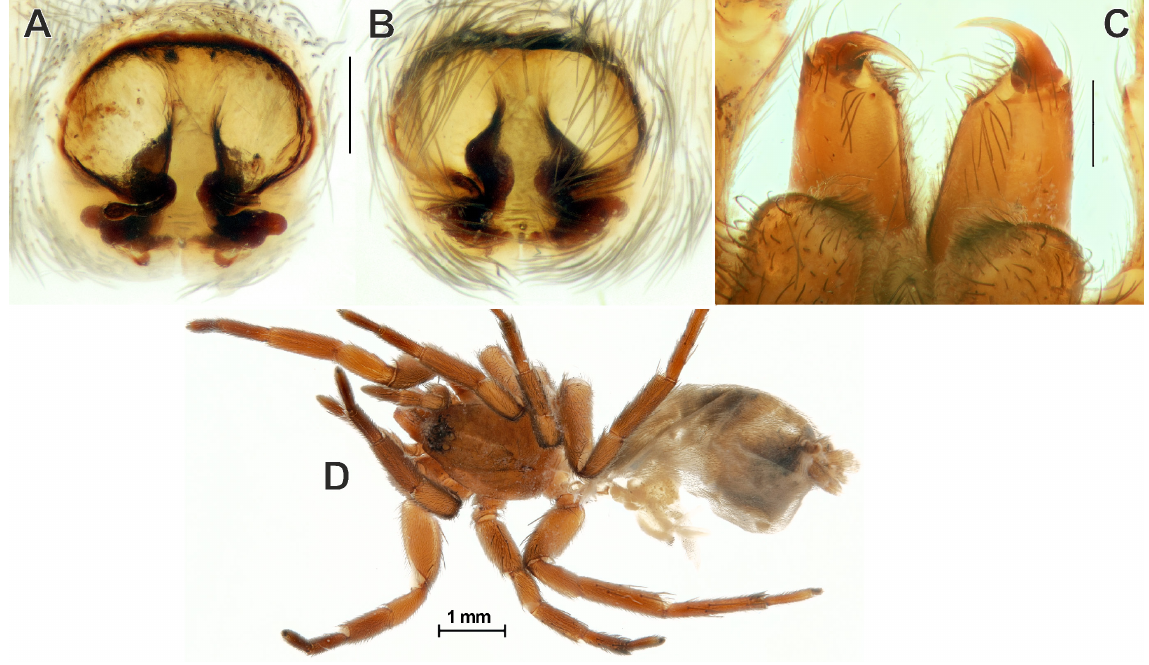
Fig. 9. Echemus caspicus sp. nov., holotype, ♀ (MHNG). A–B . Epigyne, dorsal and ventral views. C . Chelicerae, posterior view. D . Habitus, dorsal view. Scale bars: 0.2 mm, unless stated